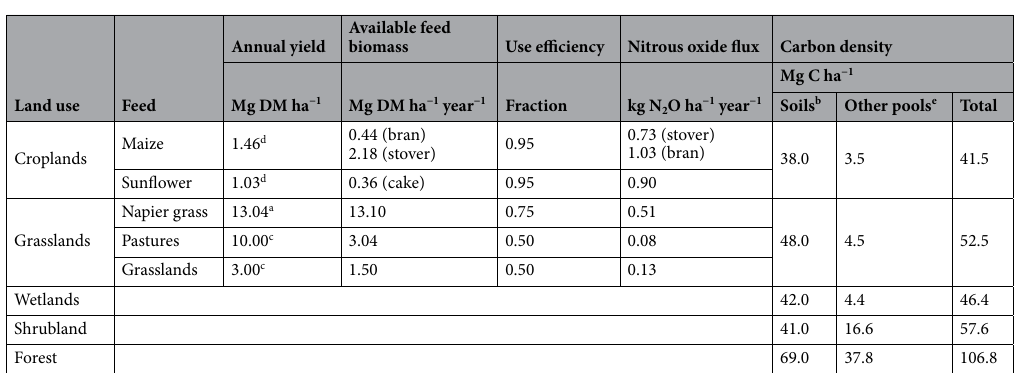
Table 1. Biomass productivity, nitrous oxide fluxes, and carbon density parameters for feed and land use categories in model. Sources: a 47 , b 48 , c 7 , d 40 , e 49 .